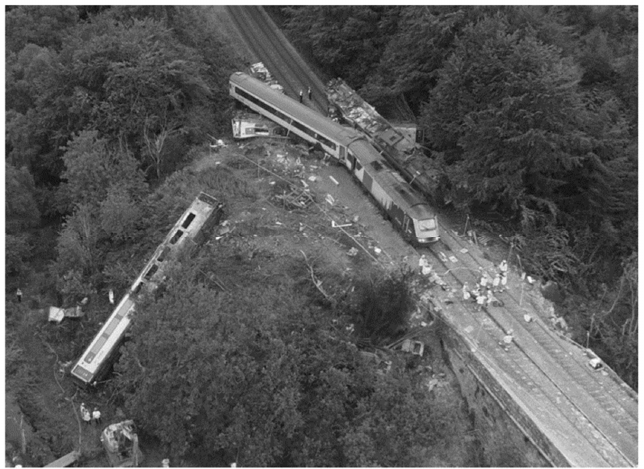
Figure 8. Aerial photograph of the Stonehaven train derailment on the 12th of August (Photo reproduced with permission of Rail Accident Investigation Branch, 2021). Undoubtedly, the performance of the geomaterials that incorporate typical transport infrastructure substructure under partially saturated conditions is also influenced by the magnitude and frequency of the dynamic loads applied. However, the timescales in which